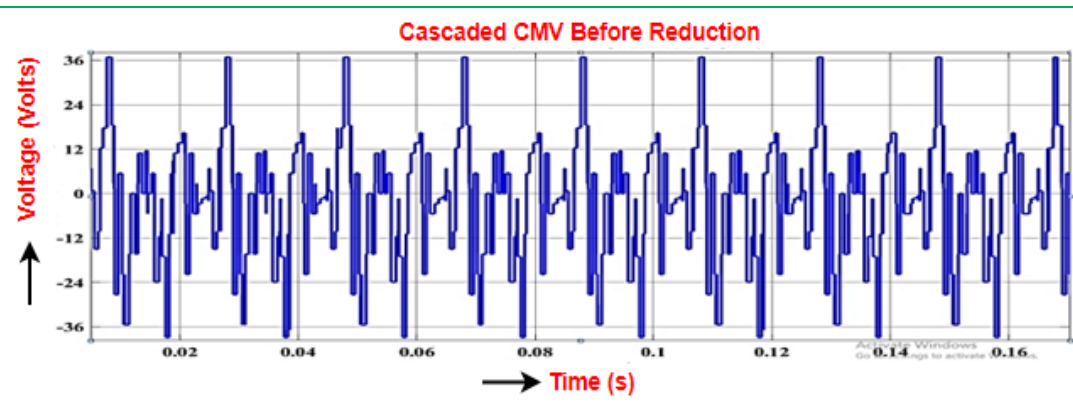
Figure 18. CMV of cascaded H ‐ bridge MLI using SPWM.